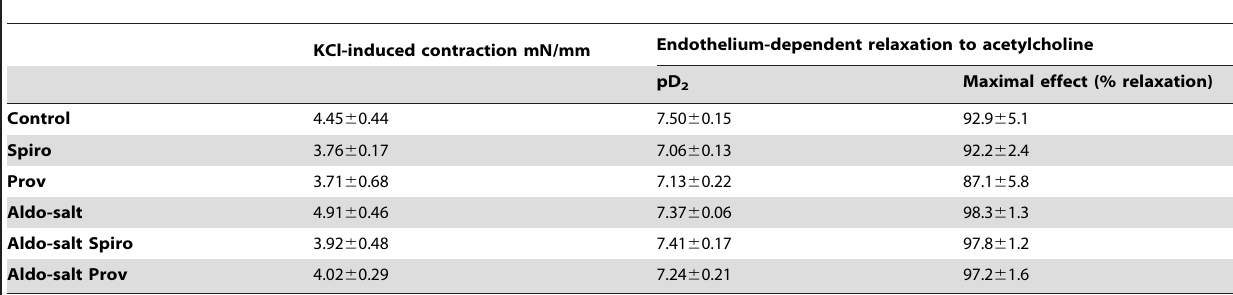
Table 3. Contractile effects of KCl (80 mM) and endothelium-dependent relaxation to acetylcholine in rat mesenteric resistance